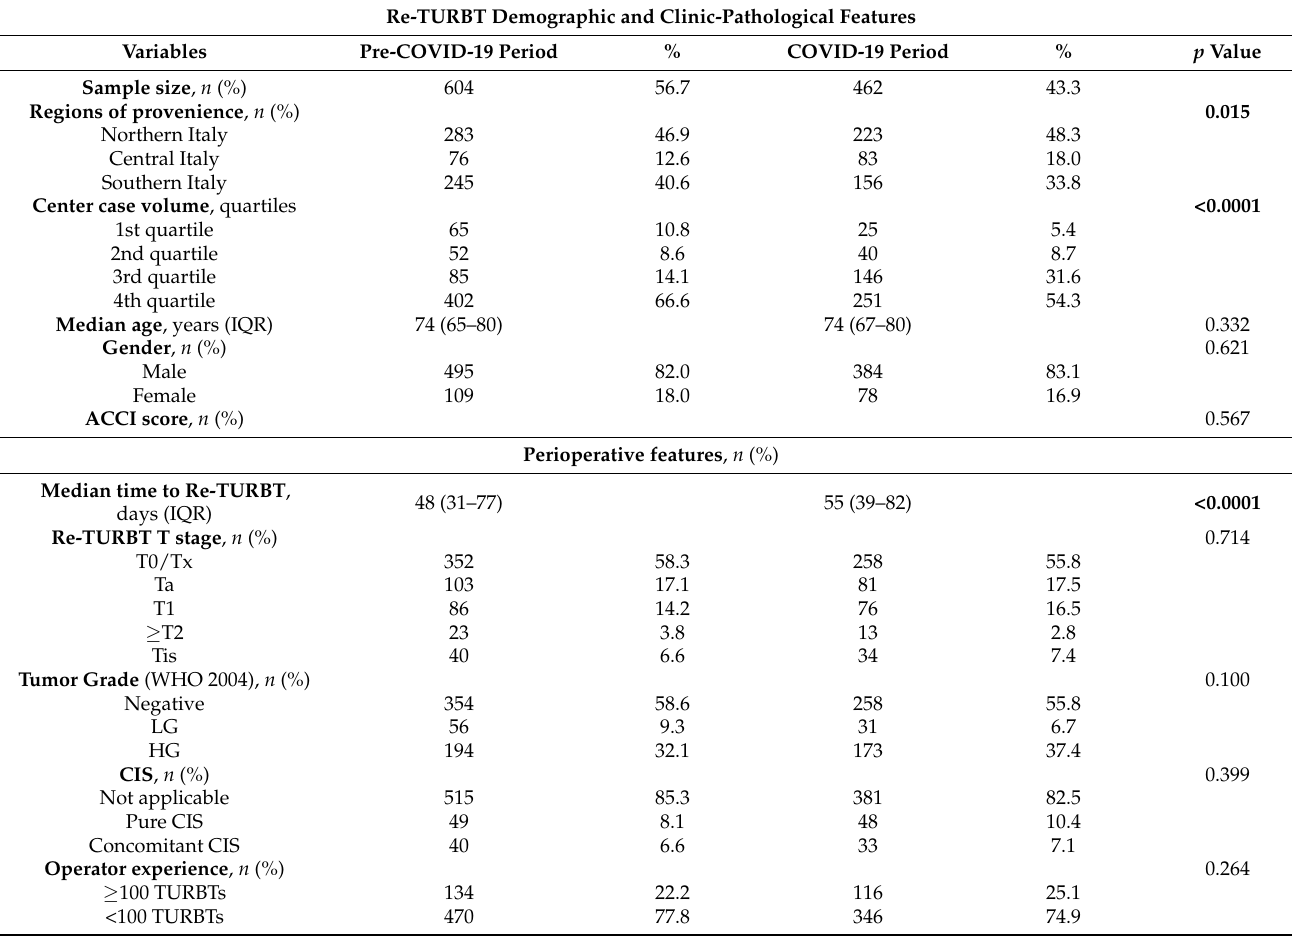
Table 2. Descriptive characteristics of Re-TURBT cohort. In bold, value < 0.05. Re-TURBT Demographic and Clinic-Pathological